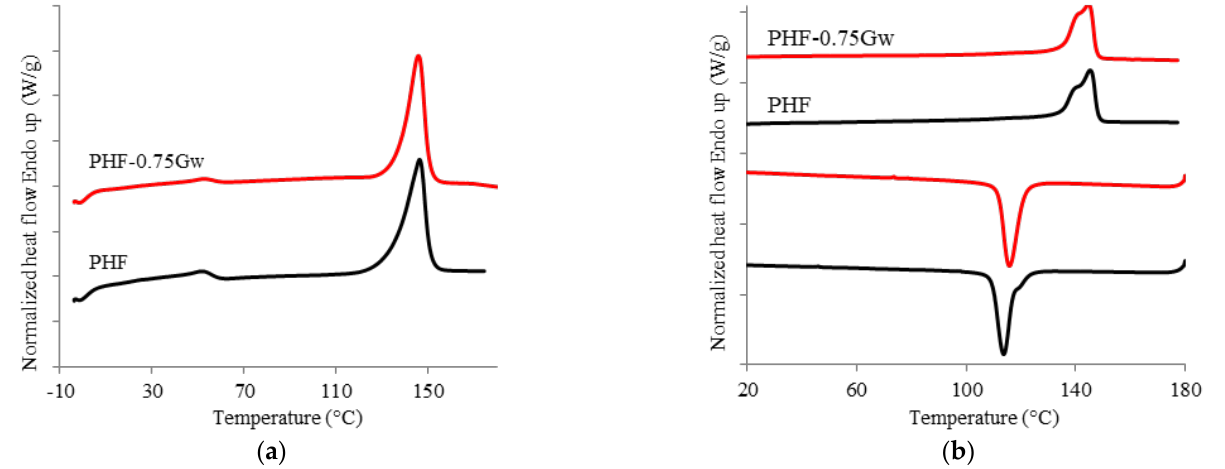
Figure 5. ( a ) Calorimetric curves of PHF and PHF-075Gw, first heating scan; ( b ) second heating scan and cooling scan.